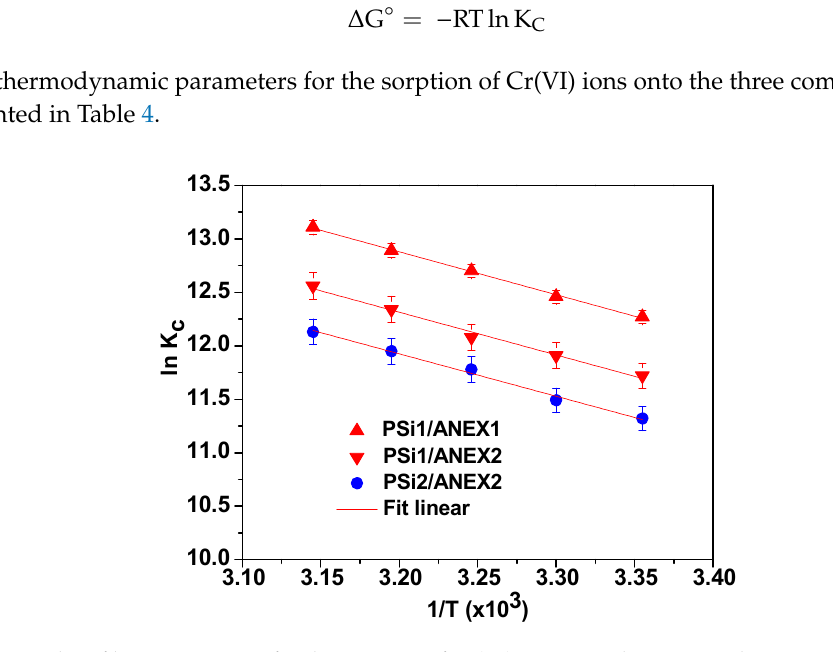
Figure 8. Plot of ln K c versus 1/T for the sorption of Cr(VI) ions onto the porous silica/ANEX composite sorbents; sorption conditions: sorbent dose 1 g/L, pH 4, C in = 100 mg/L, contact time 6 h. Table 4. Thermodynamic parameters for the sorption of Cr(VI) oxyanions onto the porous silica / ANEX composite